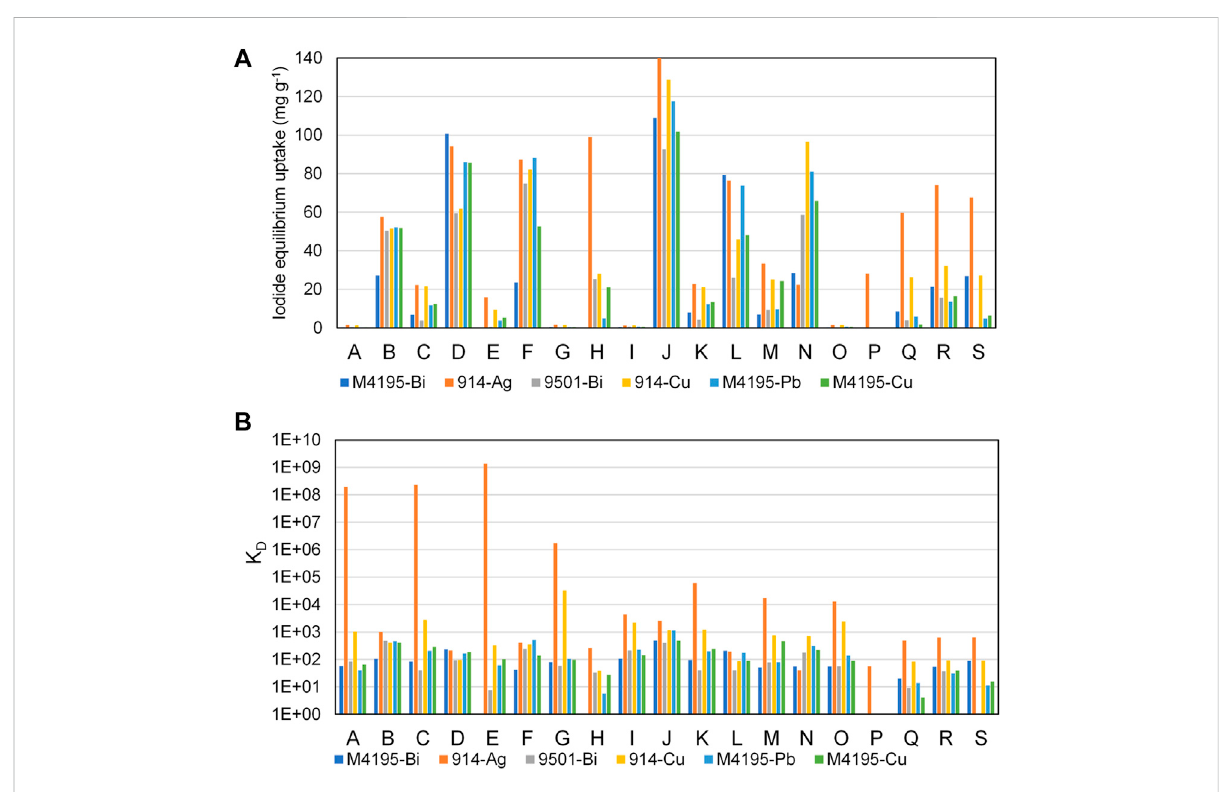
FIGURE 7 Iodide uptake capabilities of the six overall highest-performing materials, accounting for every sample solution, (A) iodide equilibirium uptake (mg · g − 1 ) and (B) K D (distribution coef fi cient (Eq. 2)). Experimental parameters are as per Figure 4 and Table 2.